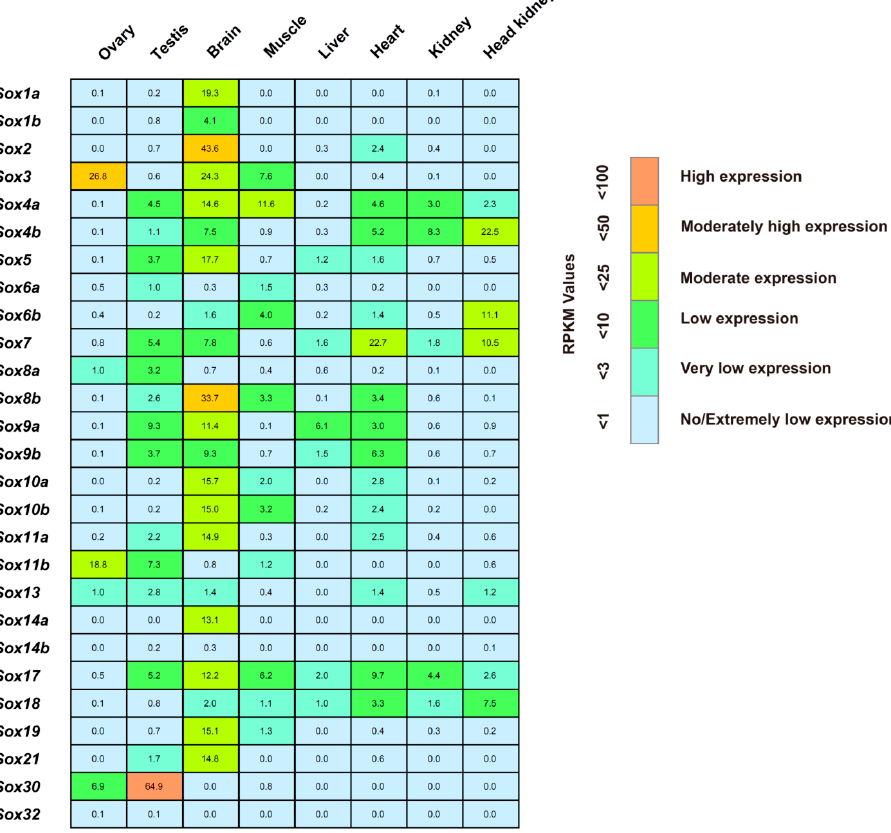
Figure 4. Spatial expression profiles of the tilapia Sox genes. The transcriptomes (NCBI accession number: PRJNA78915 and SRR1916191) of multiple tissues of the adult tilapia were used to profile spatial expression of the tilapia Sox genes. Numbers within the box indicate the RPKM values.